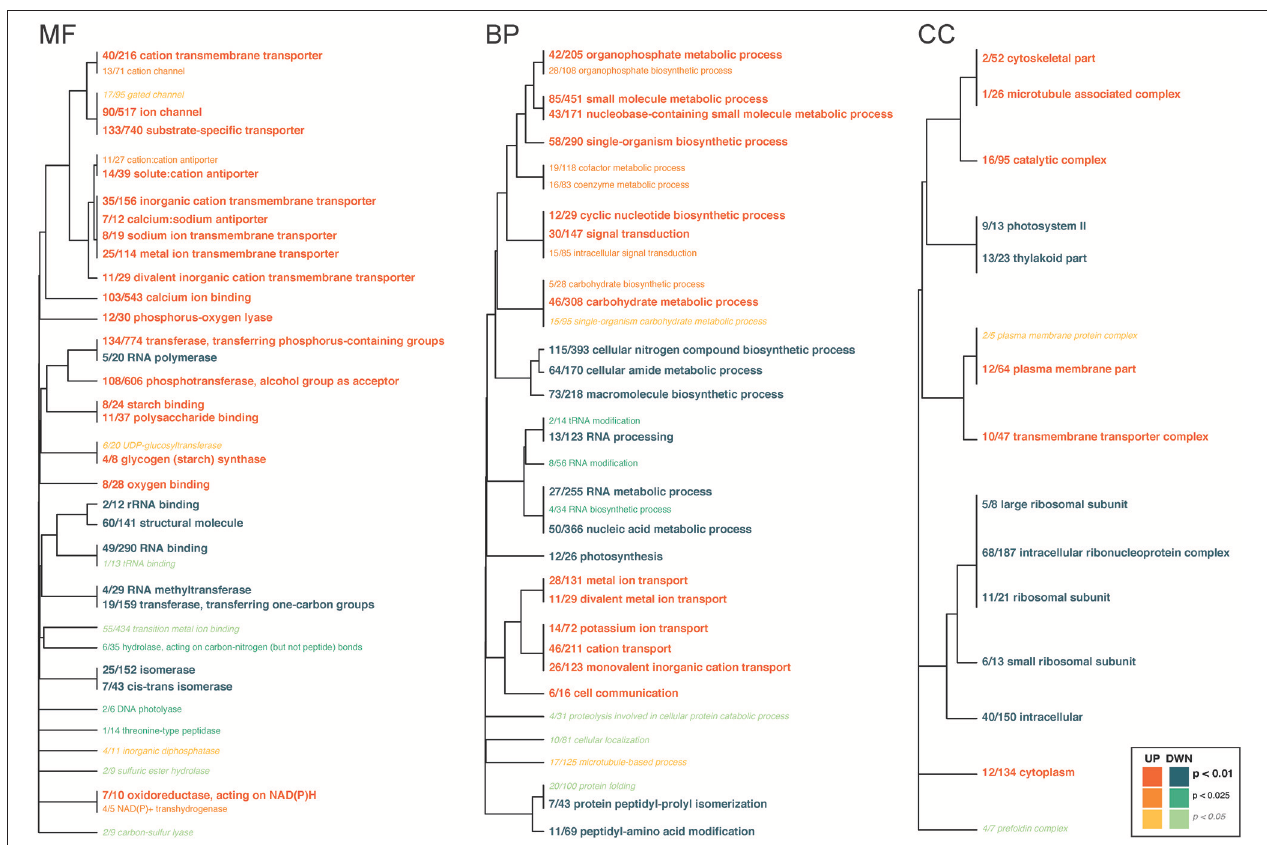
FIGURE 4 | Gene ontology categories enriched by Symbiodinium genes up-regulated (shades of orange) or down-regulated (shades of turquoise) in response to OA, summarized by molecular function (MF), biological process (BP), and cellular component (CC). The size of the text and darkness of the color indicate the significance of the term as indicated by the inset key. The fraction preceding each GO term indicates the proportion of genes annotated with the term that pass an unadjusted p -value threshold of 0.05. The trees indicate sharing of genes among GO categories (the categories with no branch length between them are subsets of each